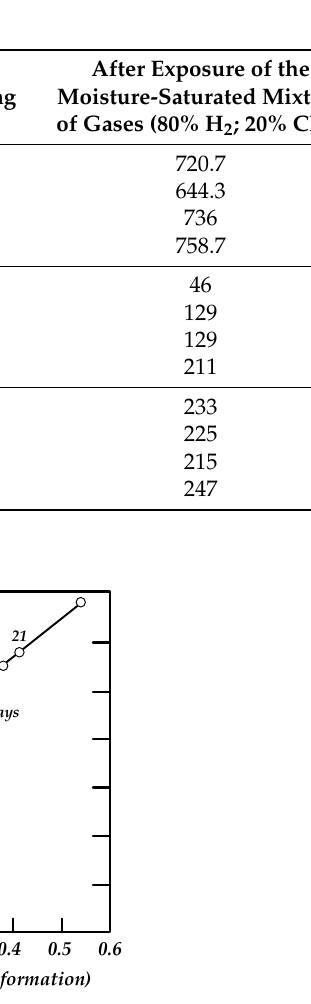
Table 5. Mechanical properties of the studied steel grades before and after exposure to an aggressive environment with different hydrogen concentrations [49].